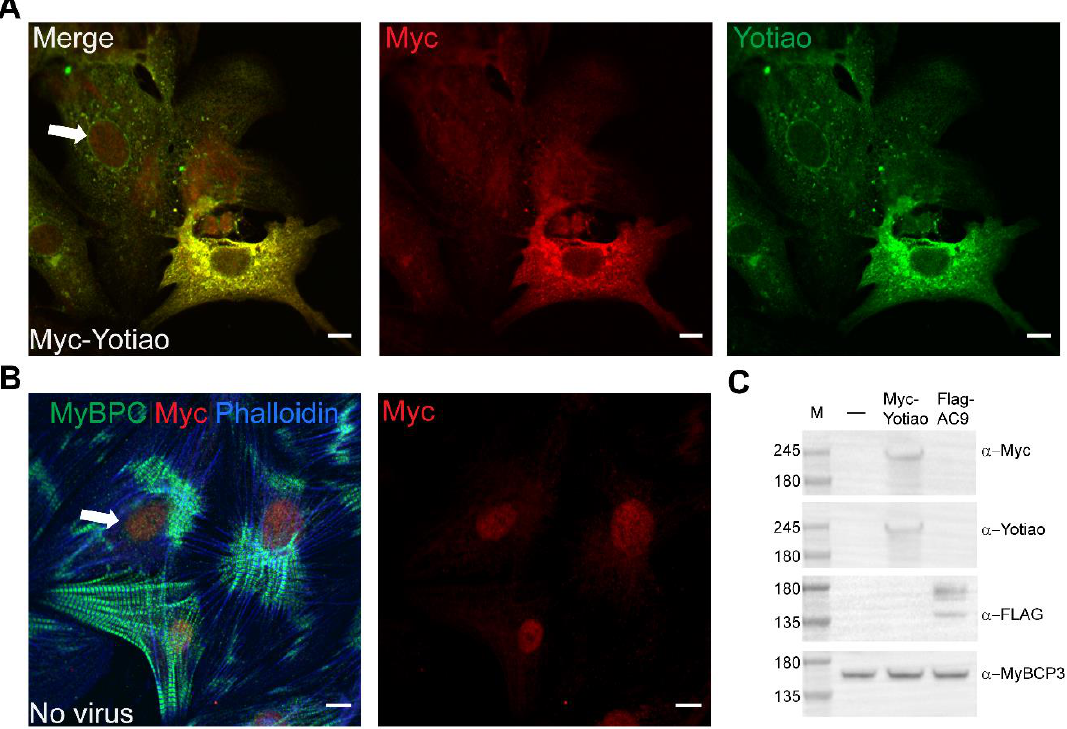
Figure 6. Validation of Yotiao Antibody. ( A ) Neonatal rat CMs were infected with Myc-Yotiao for 60 h and stained with Myc (red) and Yotiao (green). Separate channels are shown to the right of the composite. ( B ) Control cells were stained with myosin binding protein C 3 (MyBPC) (green), Myc (red), and phalloidin (blue). A separate image of Myc staining is shown to the right of the composite image. Note, non-specific nuclear staining of Myc (arrows). Scale bar represents 10 µm ( A – B ). Images are representative of >10 CMs per condition from ≥2 isolations. ( C ) Equal protein lysates from neonatal rat CMs were subjected to western blot analysis with anti-Myc, Yotiao, FLAG, and MyBPC3. M (marker).